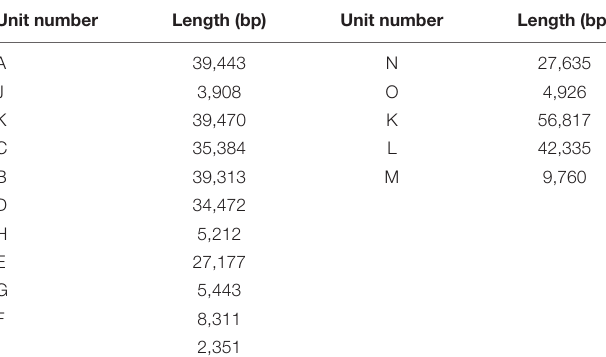
TABLE 1 | Lengths of primary scaffolds used for the assembly of T. esculentum mitochondrial